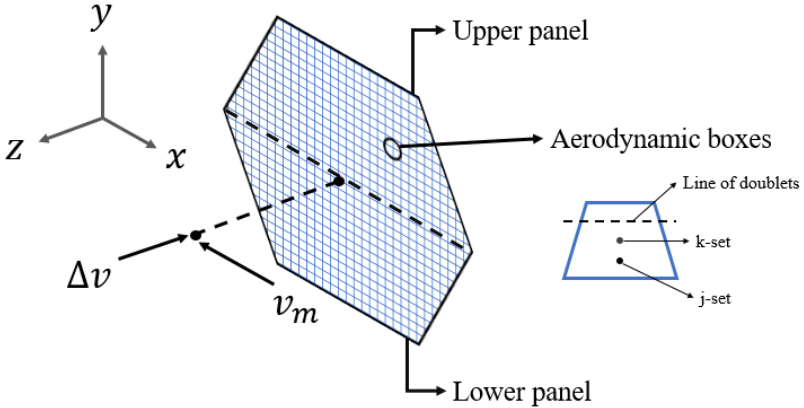
Figure 5. DLM panels modelling of the aerodynamic surfaces of the truss-like antenna frame.